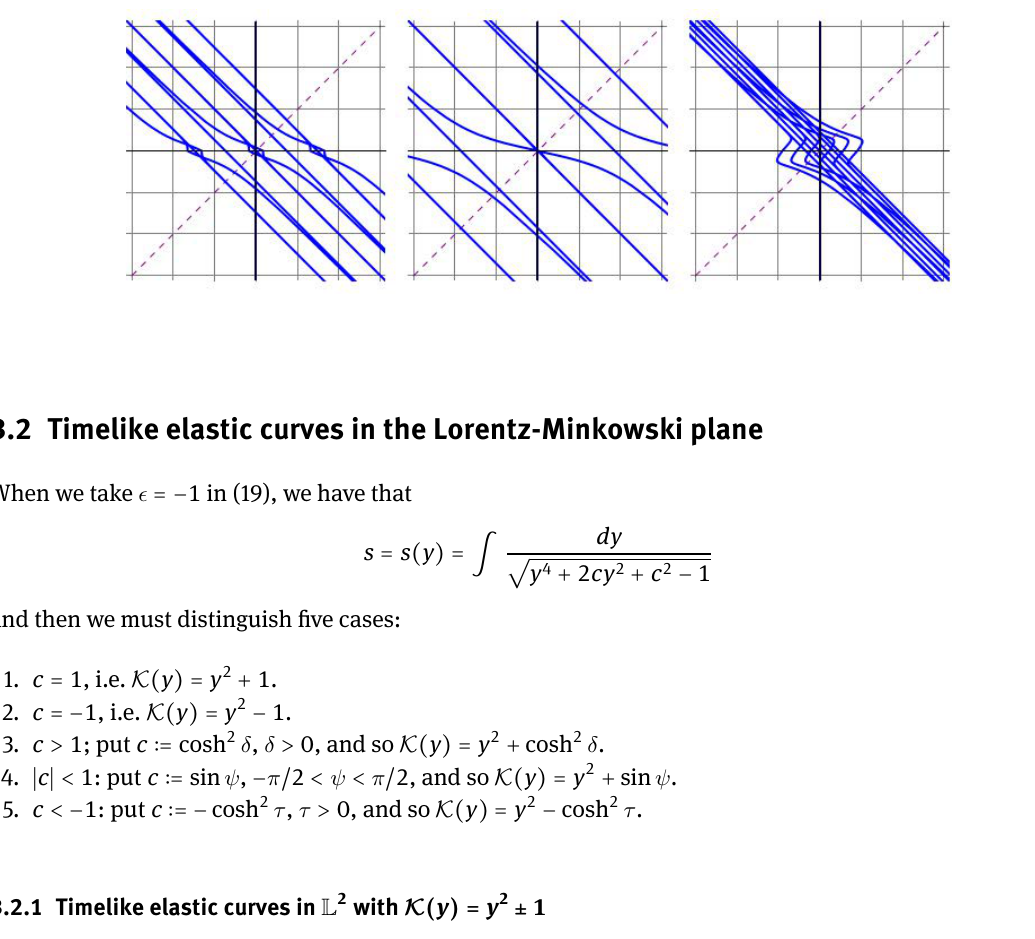
Fig. 6. Spacelike elastic curves α η ( η = 0,1.5, − 1.5